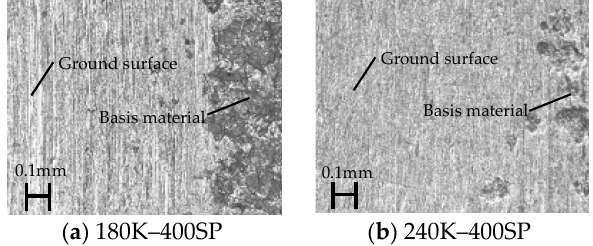
Figure 11. Condition of the steel sheet after grinding with the 180K–400SP and 240K–400SP combinations.